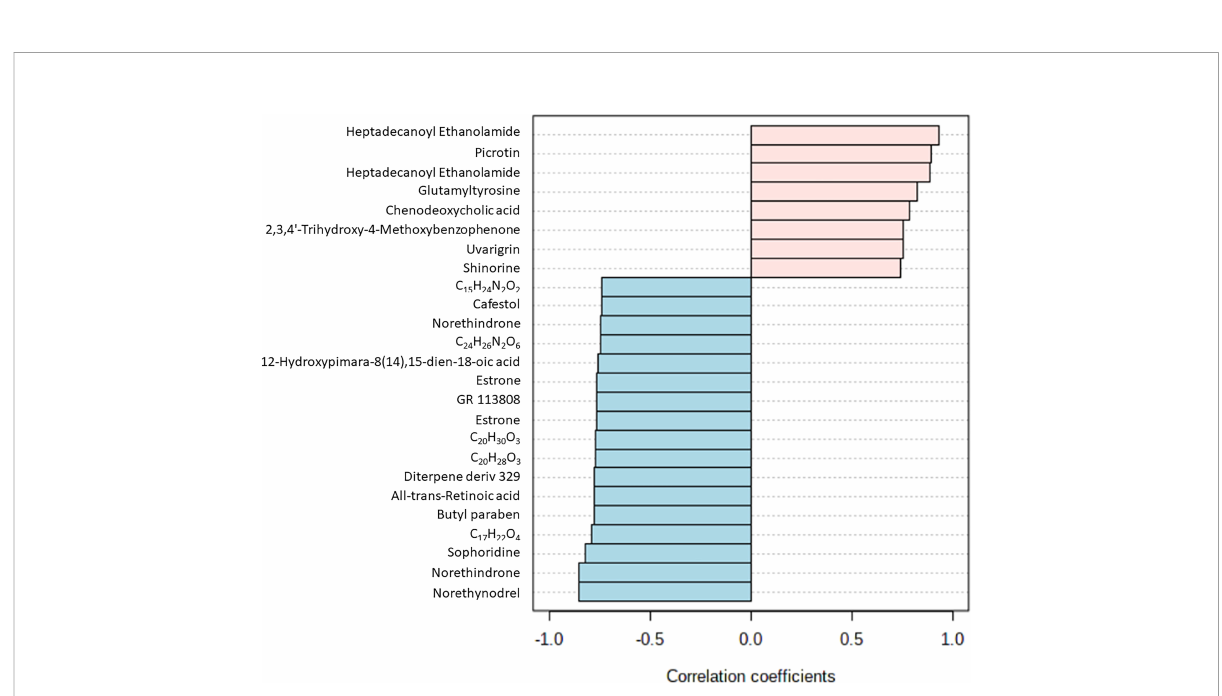
FIGURE 4 Top 25 metabolites with highest/lowest correlation coef fi cient from Pearson ’ s correlation